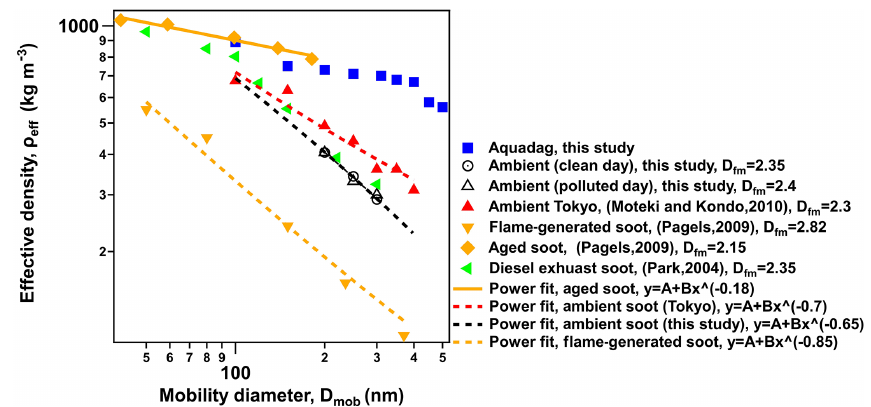
Figure 9. Relationship between effective density and mobility diameter of rBC-containing particles. The black circle and triangle denote the fresh rBC-containing particles ( D p /D c = 1) measured on clean days and polluted days in this study. Other markers denote the data from previous